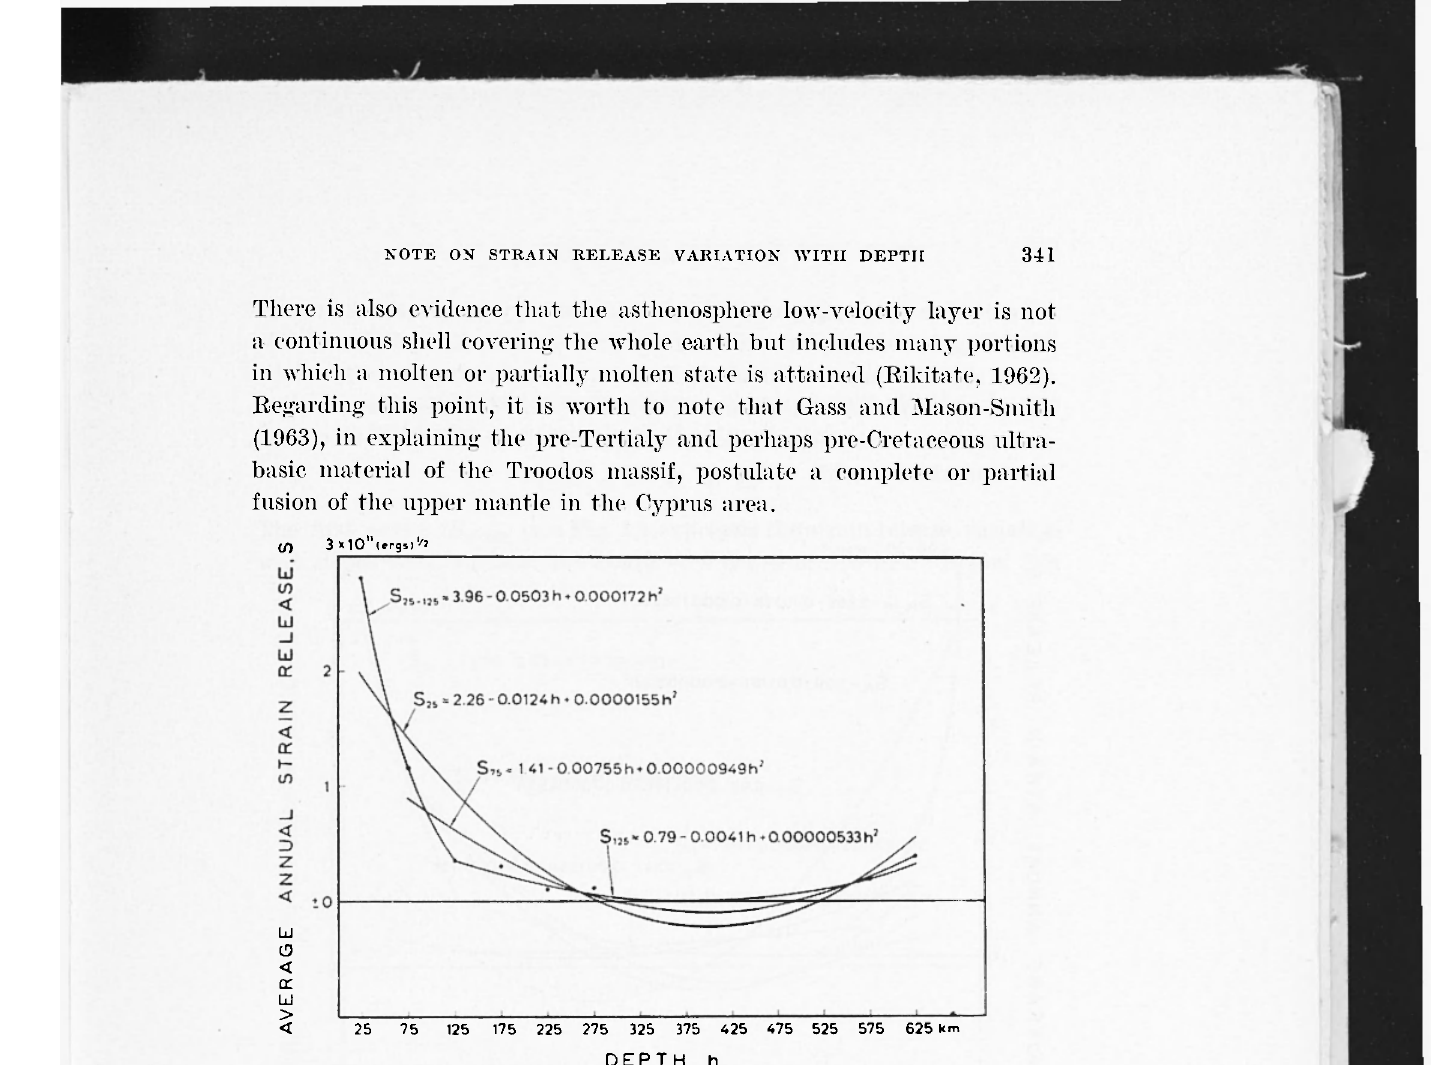
Fig. 3 - Strain release variation with depth in South America.